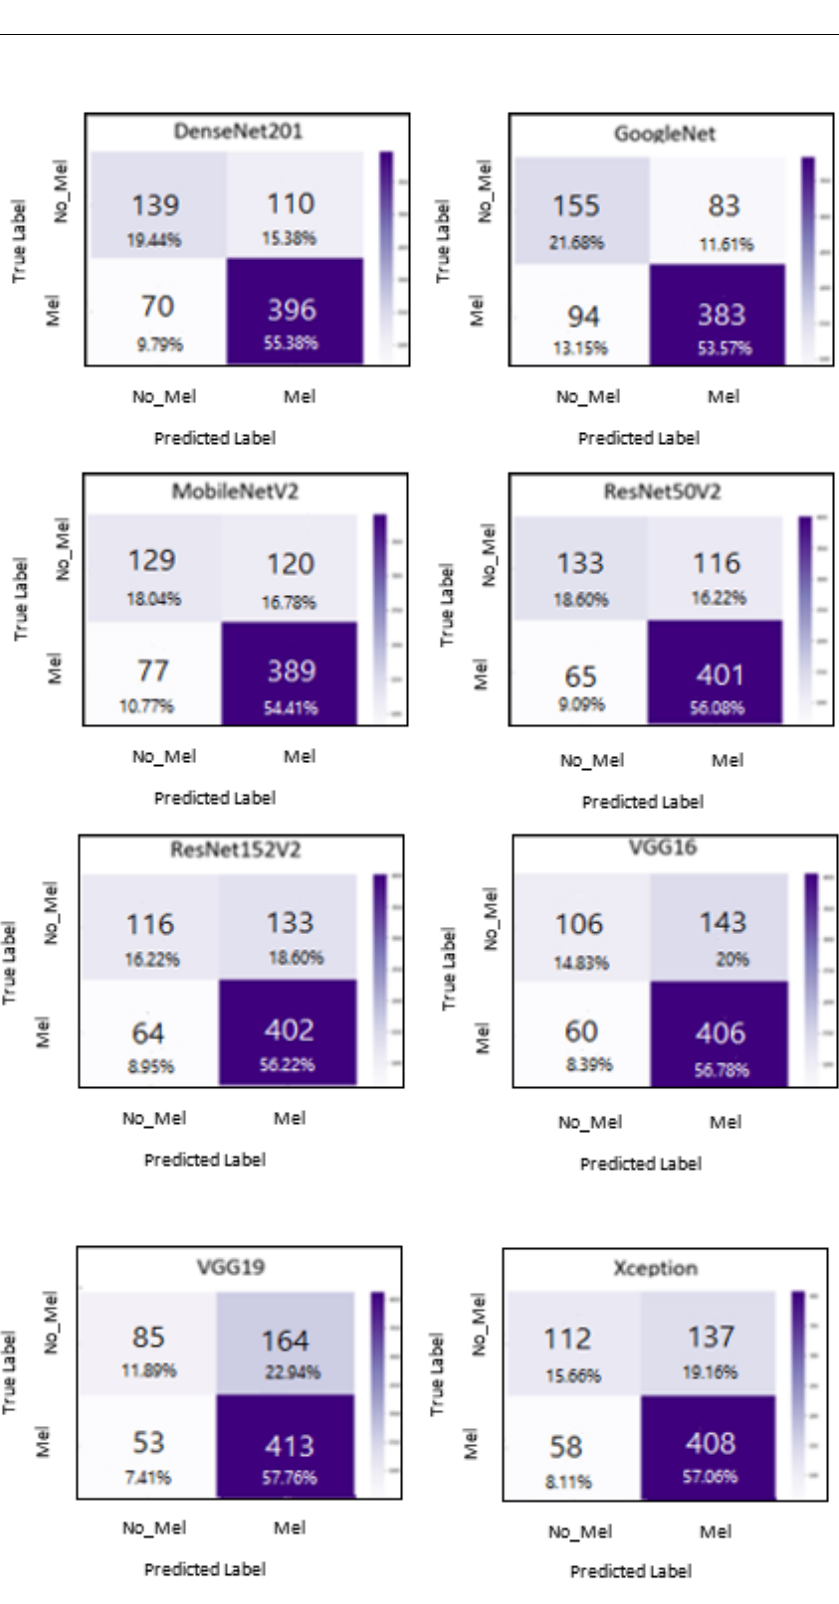
Figure 5. Confusion matrices for all architectures used in the